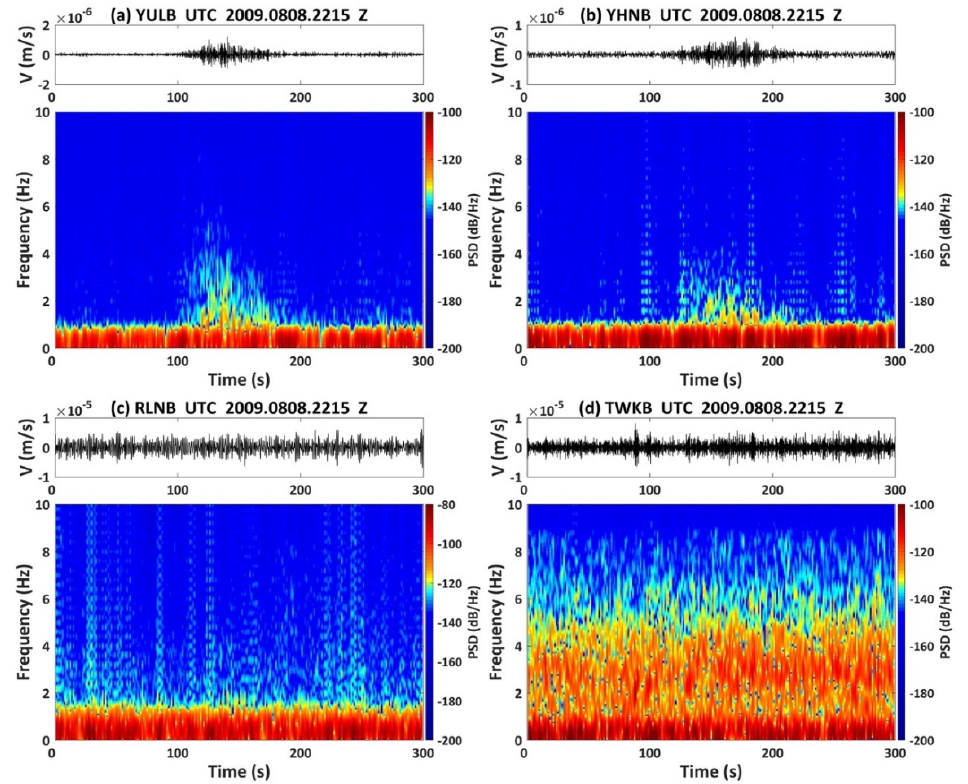
Figure 2. Four seismograms with corresponding time series and spectrogram views of the Xiaolin landslide.